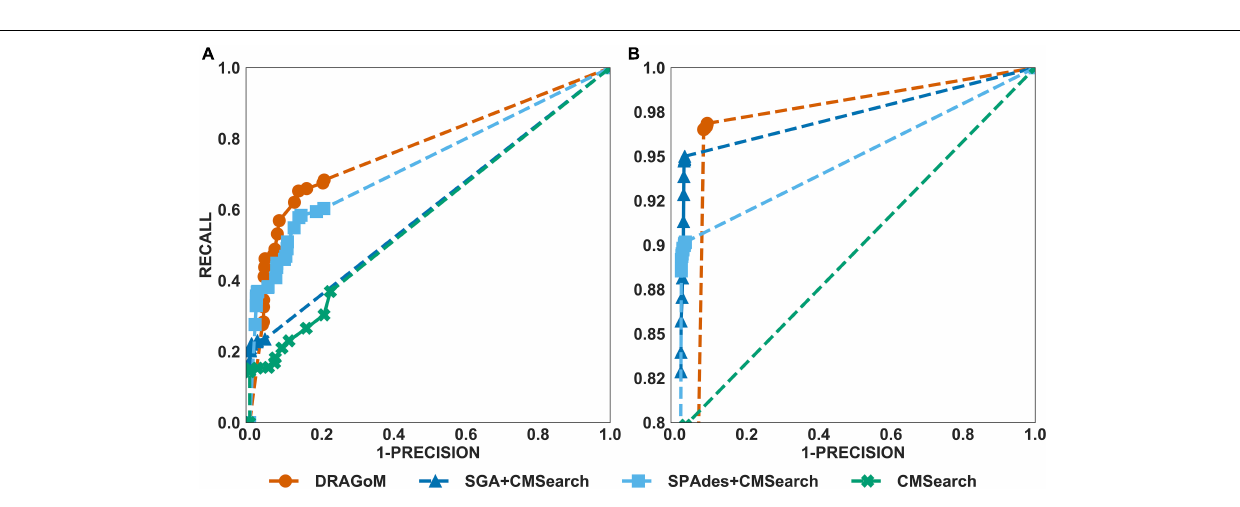
FIGURE 5 | The ROC curves for searching (A) 60 non-16S rRNAncRNA families and (B) 16S rRNAs using the corresponding programs against DS4 (the subsampled human gut